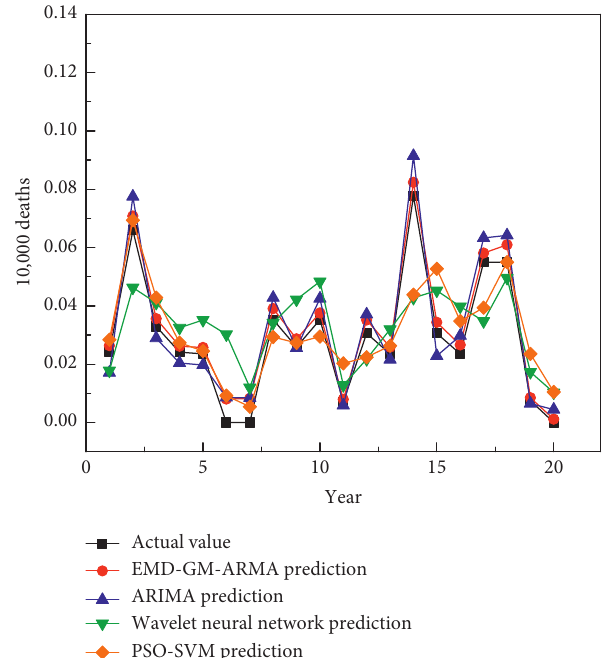
Figure 15: Comparative analysis of predicted values of models.